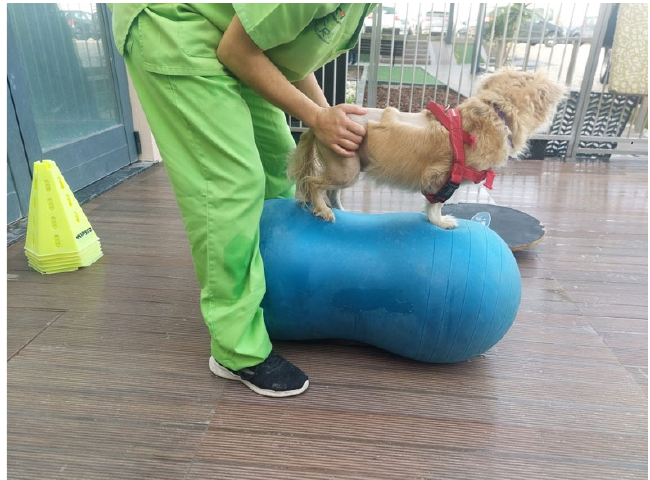
Figure 6. Assisted postural standing position of a dog on a physioball.